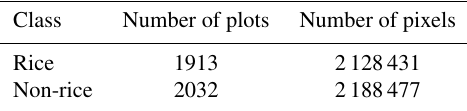
Table 3. Information of the validation sample